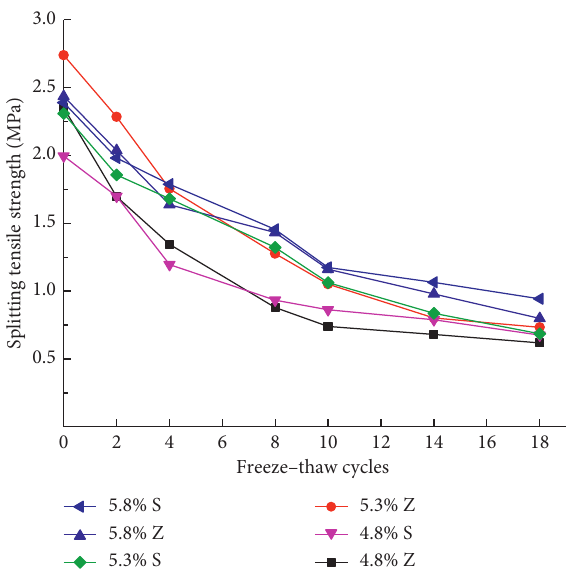
Figure 3: Curves of splitting tensile strength versus freeze-thaw